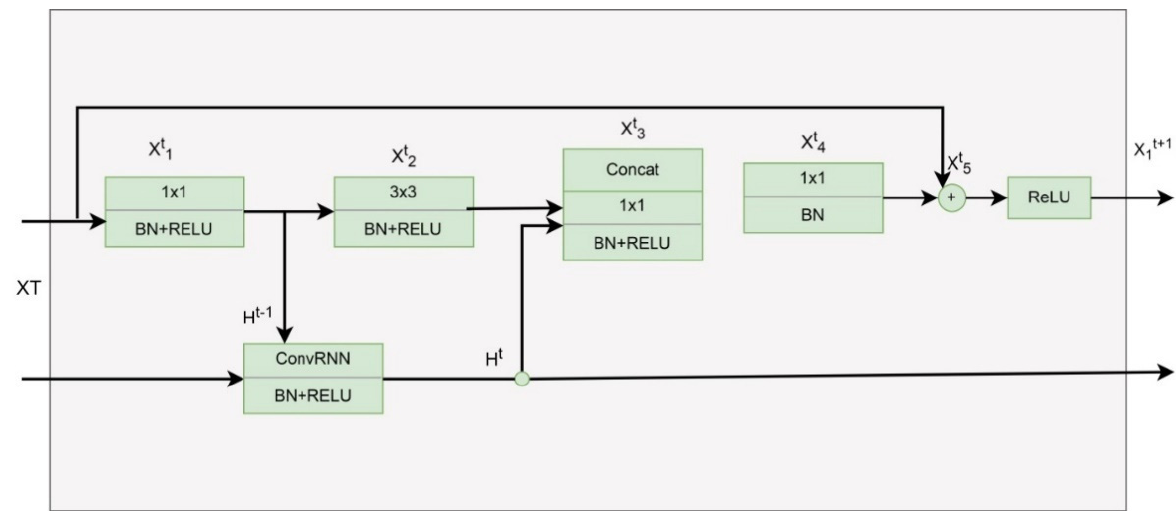
Figure 4. RegNetY-320 architecture.